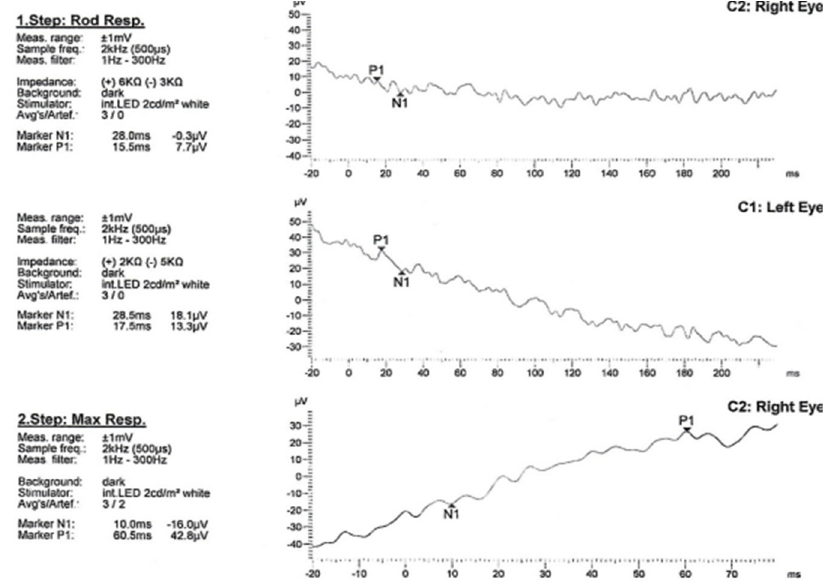
Int. J. Mol. Sci. 2022 , 23 , 7582 Figure 3. ( A ) Visual field of the right eye; ( B ) visual field of the left eye. Figure 3. ( A ) Visual field of the right eye; ( B ) visual field of the left eye. Figure 3. ( A ) Visual field of the right eye; ( B ) visual field of the left eye.